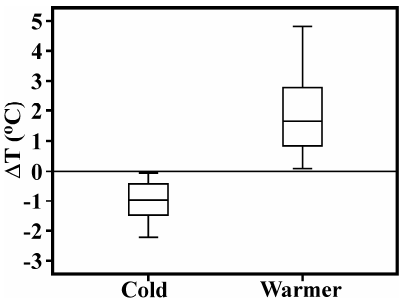
Figure 4. Box plot of post-storm thermal change (ΔT) within the substrate among all the multi-level samplers. The box represents the middle 50% of the data (interquartile range). The lower and upper edges of the box represent the 25th and 75th percentiles, respectively. The middle band of the box represents the median and the upper and lower whiskers represent the maximum and the minimum data values, respectively.